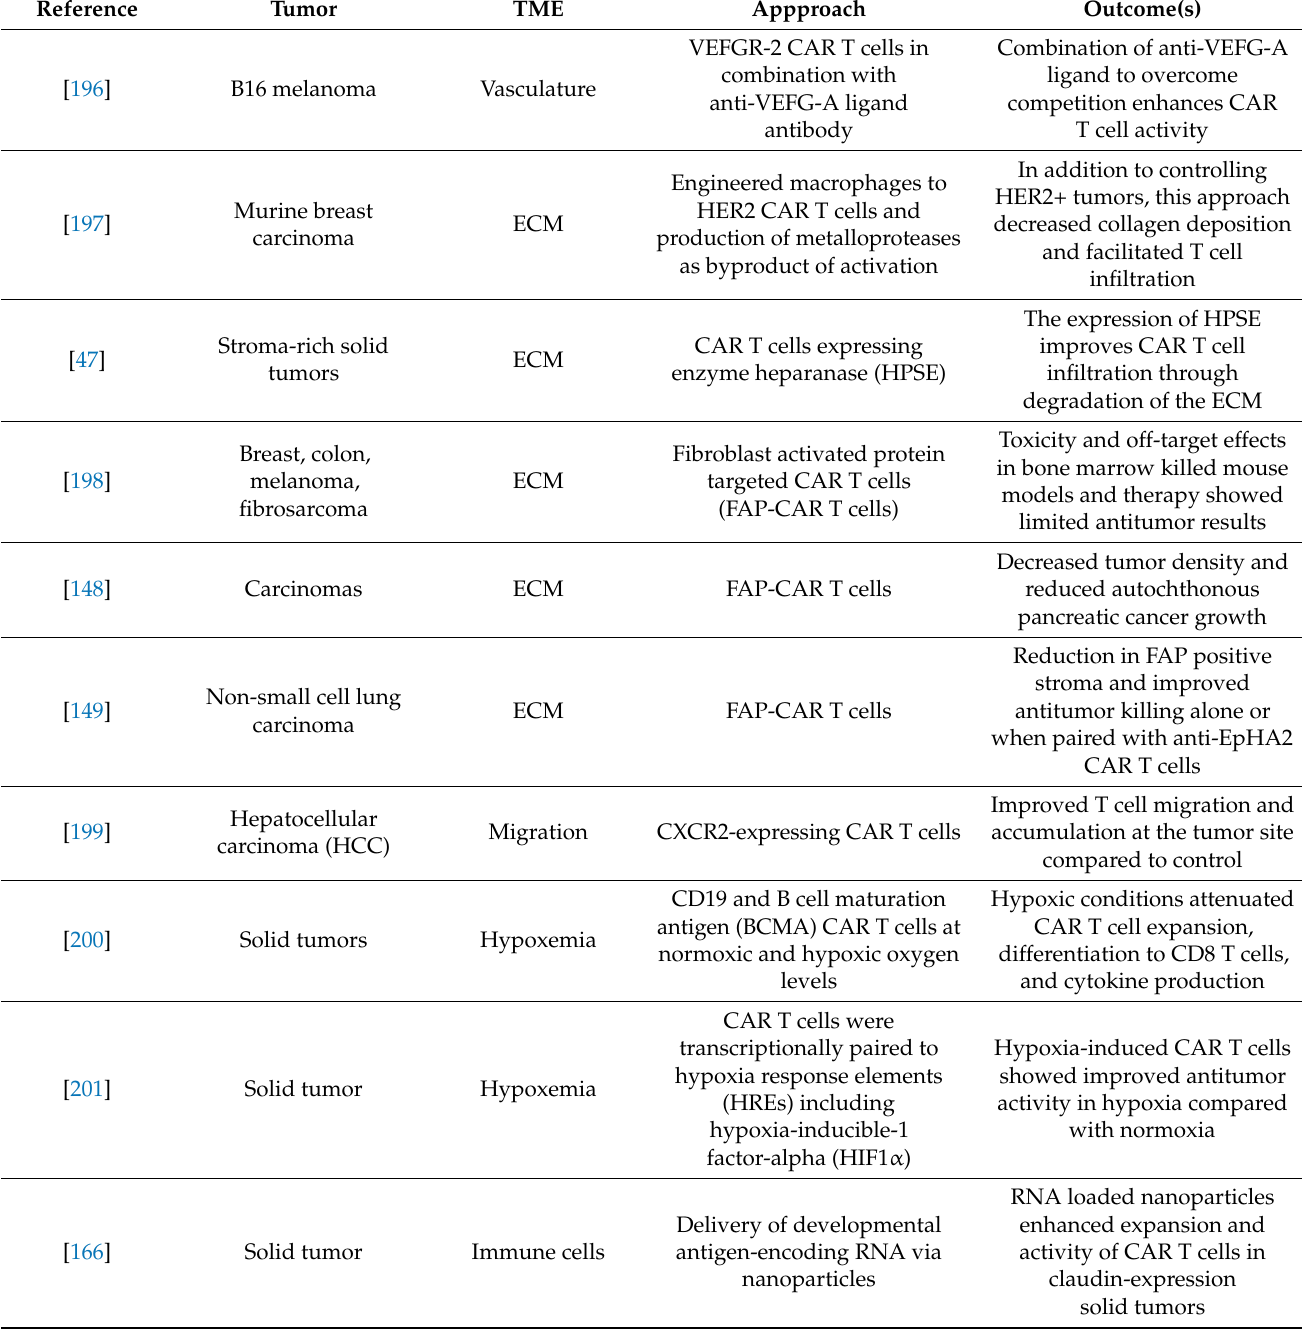
Table 1. Preclinical CAR T cell approaches to improve